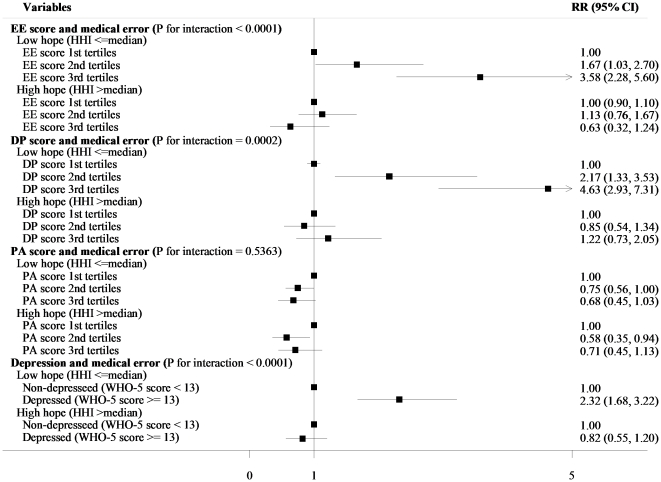
Association between burnout and medical errors: subgroup analysis by depressive symptoms evaluated by WHO-5 or Herth Hope Index score among practicing physicians, males and females, 2009.WHO-5, World Health Organization-Five Well-being Index; HHI, Herth Hope Index; IRR, Incidence rate ratio adjusted for age and sex.